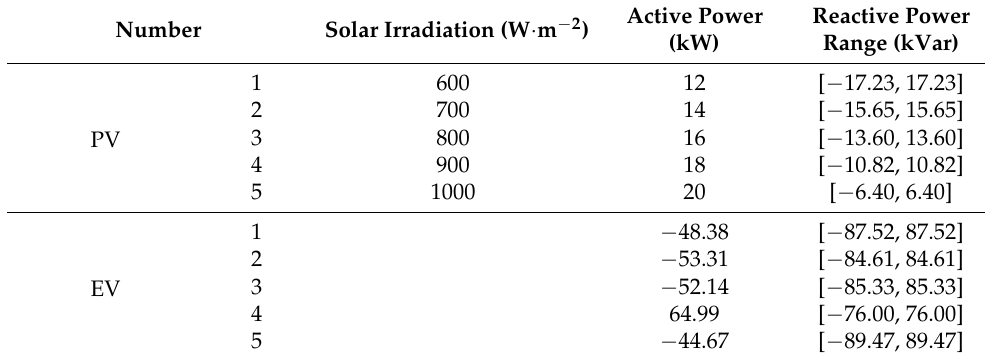
Table 2. Parameters of PV and EV stations in the IEEE 33-bus distribution system.